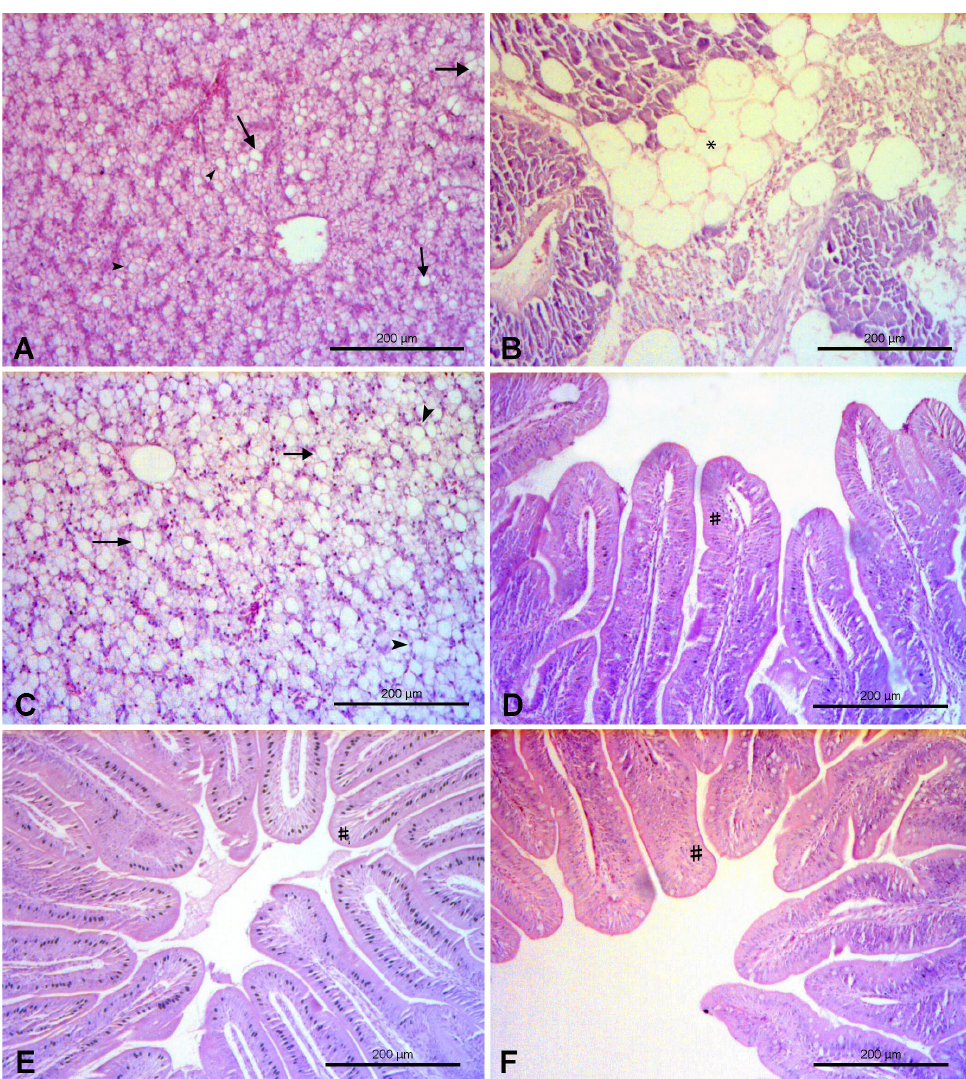
Figure 3. Liver and midgut histopathology. ( A ) FM group. Mild accumulation of lipid droplets (arrow) in liver cells. Some of the nuclei (arrowhead) of the liver cells are pushed to the edge of the cells by lipid droplets. ( B ) ZM10 group. Macrosteatosis (*) around the pancreatic islets. ( C ) ZM20 group. Moderate accumulation of lipid droplets (arrow) in liver cells. Some of the nuclei (arrowhead) of the liver cells are pushed to the edge of the cells. by lipid droplets ( D ) FM group. Normal midgut villi structure with normal enterocytes (#). ( E ) ZM10 group. Normal midgut villi structure with normal enterocytes (#). ( F ) ZM20 group. Normal midgut villi structure with normal enterocytes (#).